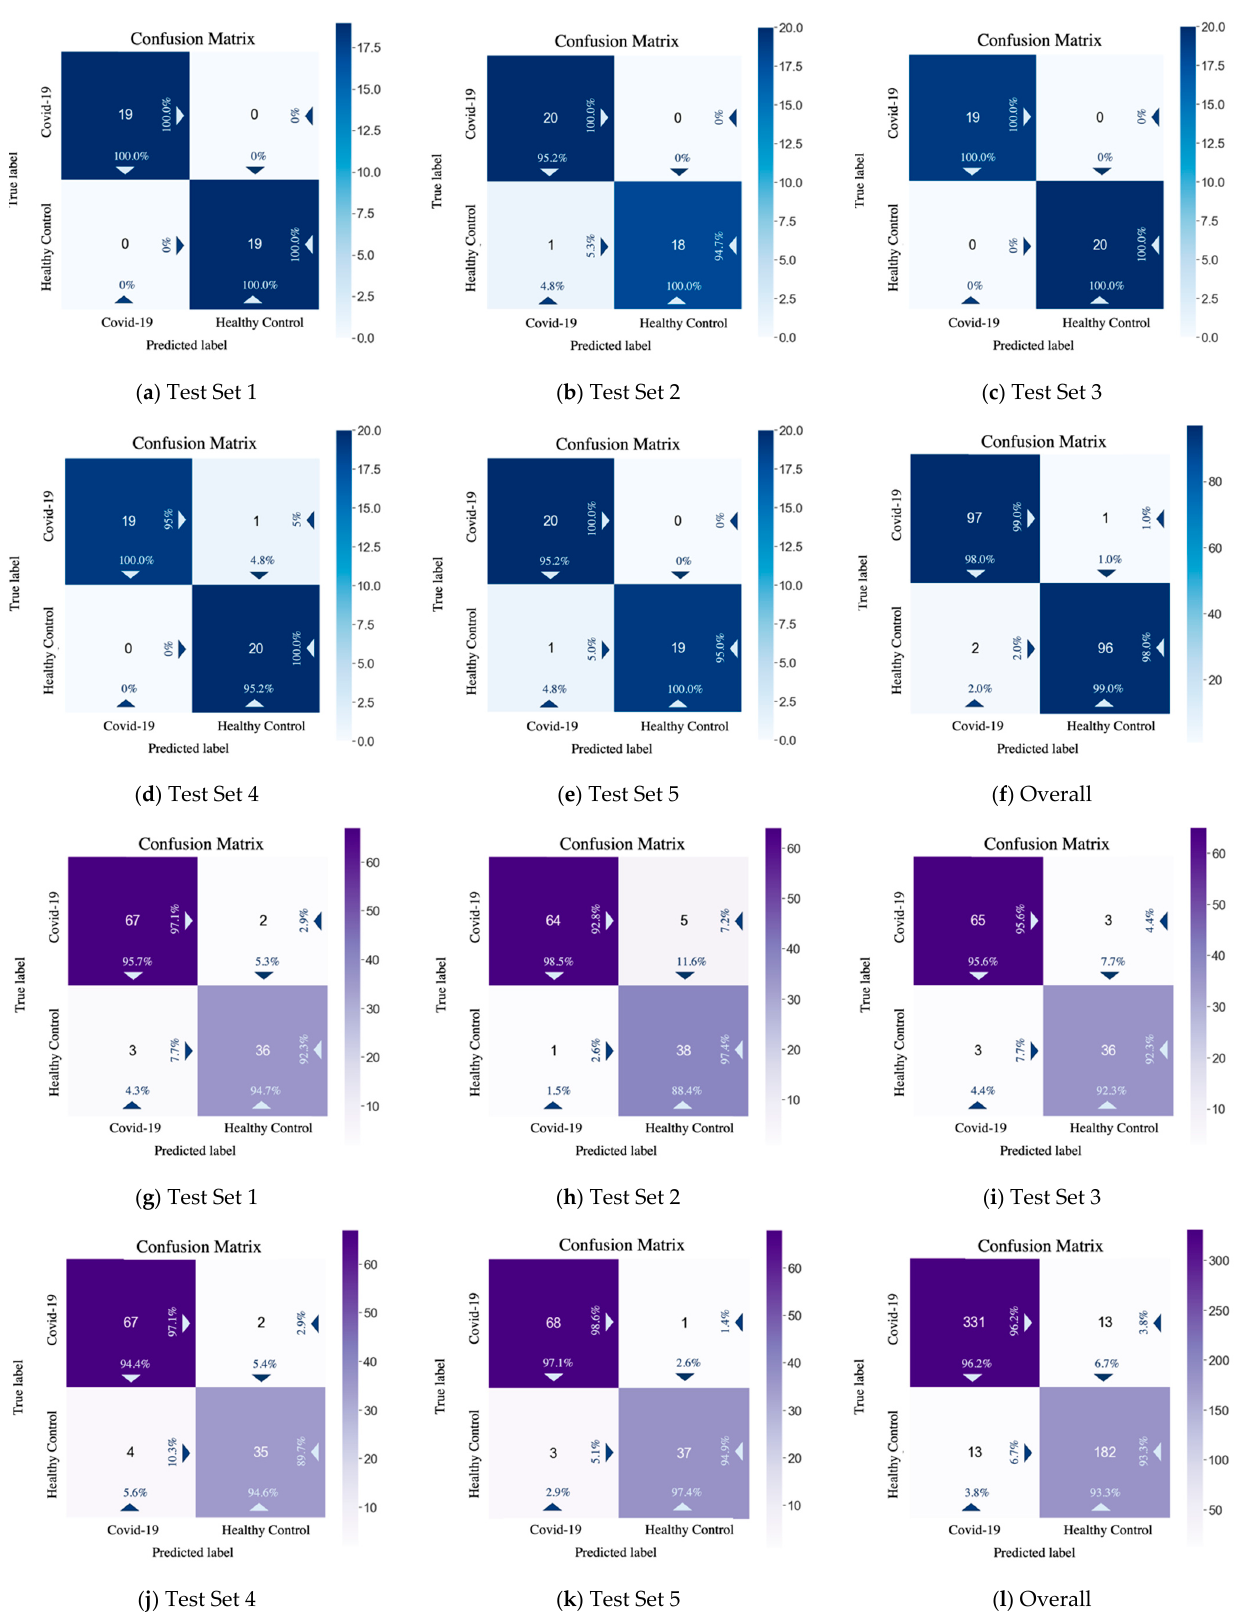
Figure 11. Confusion matrix results on Test Sets by CSGBBNet. ( a – f ): The results on the COVID Academic dataset. ( g – l ): The results on the COVID-CT dataset.